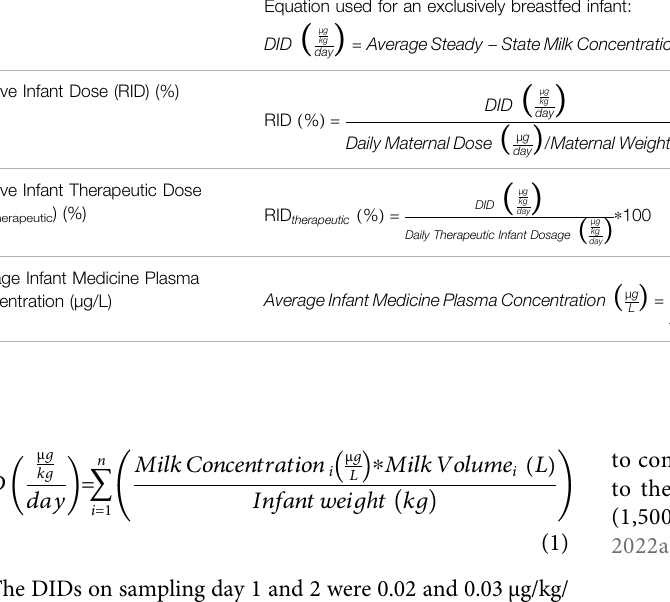
TABLE 3 | Equations used throughout the case report. Parameter Equation Equation used for the mother-infant